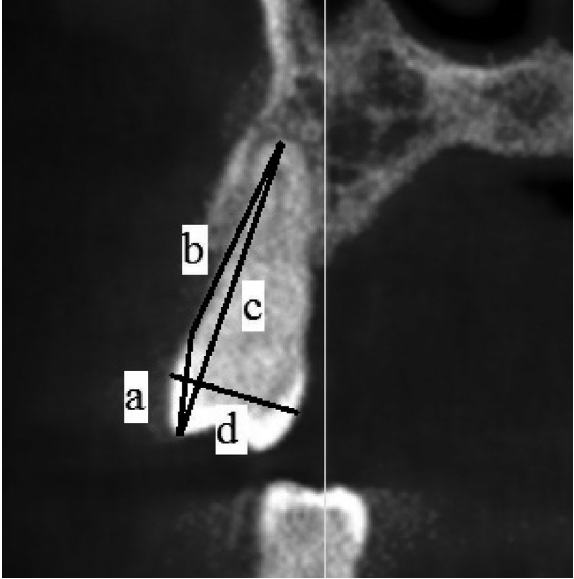
Figure 1- Demonstration for measuring tooth sizes. a: Crown length; b: Root length; c: Tooth length; d: Buccolingual